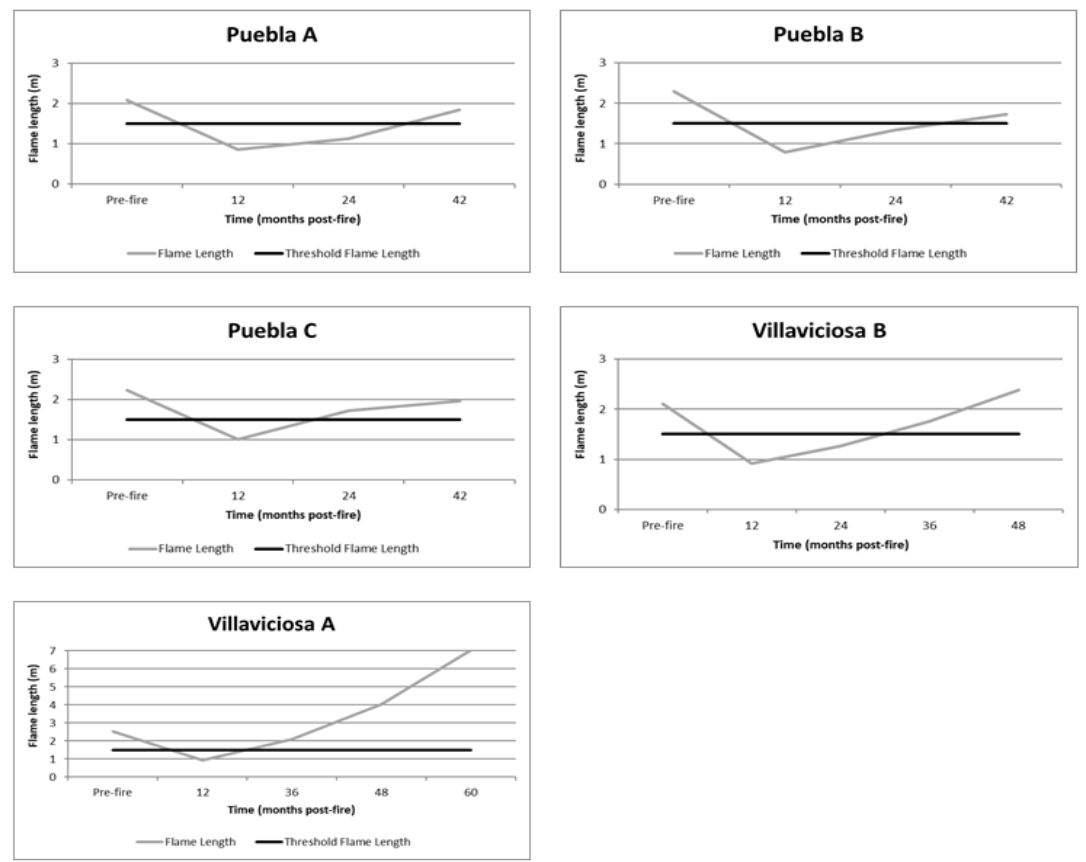
Figure 6. Evolution of flame length in Groups B (Puebla A, Puebla B, Puebla C, Villaviciosa B) and C (Villaviciosa A). A flame length threshold (1.5 m) was established by a direct firefighting attack with hand tools.